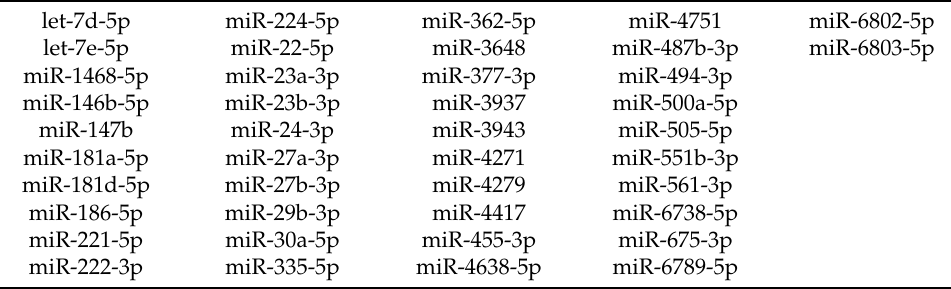
Table 4. The common DE miRs in urine, plasma, and tissue samples of PCa